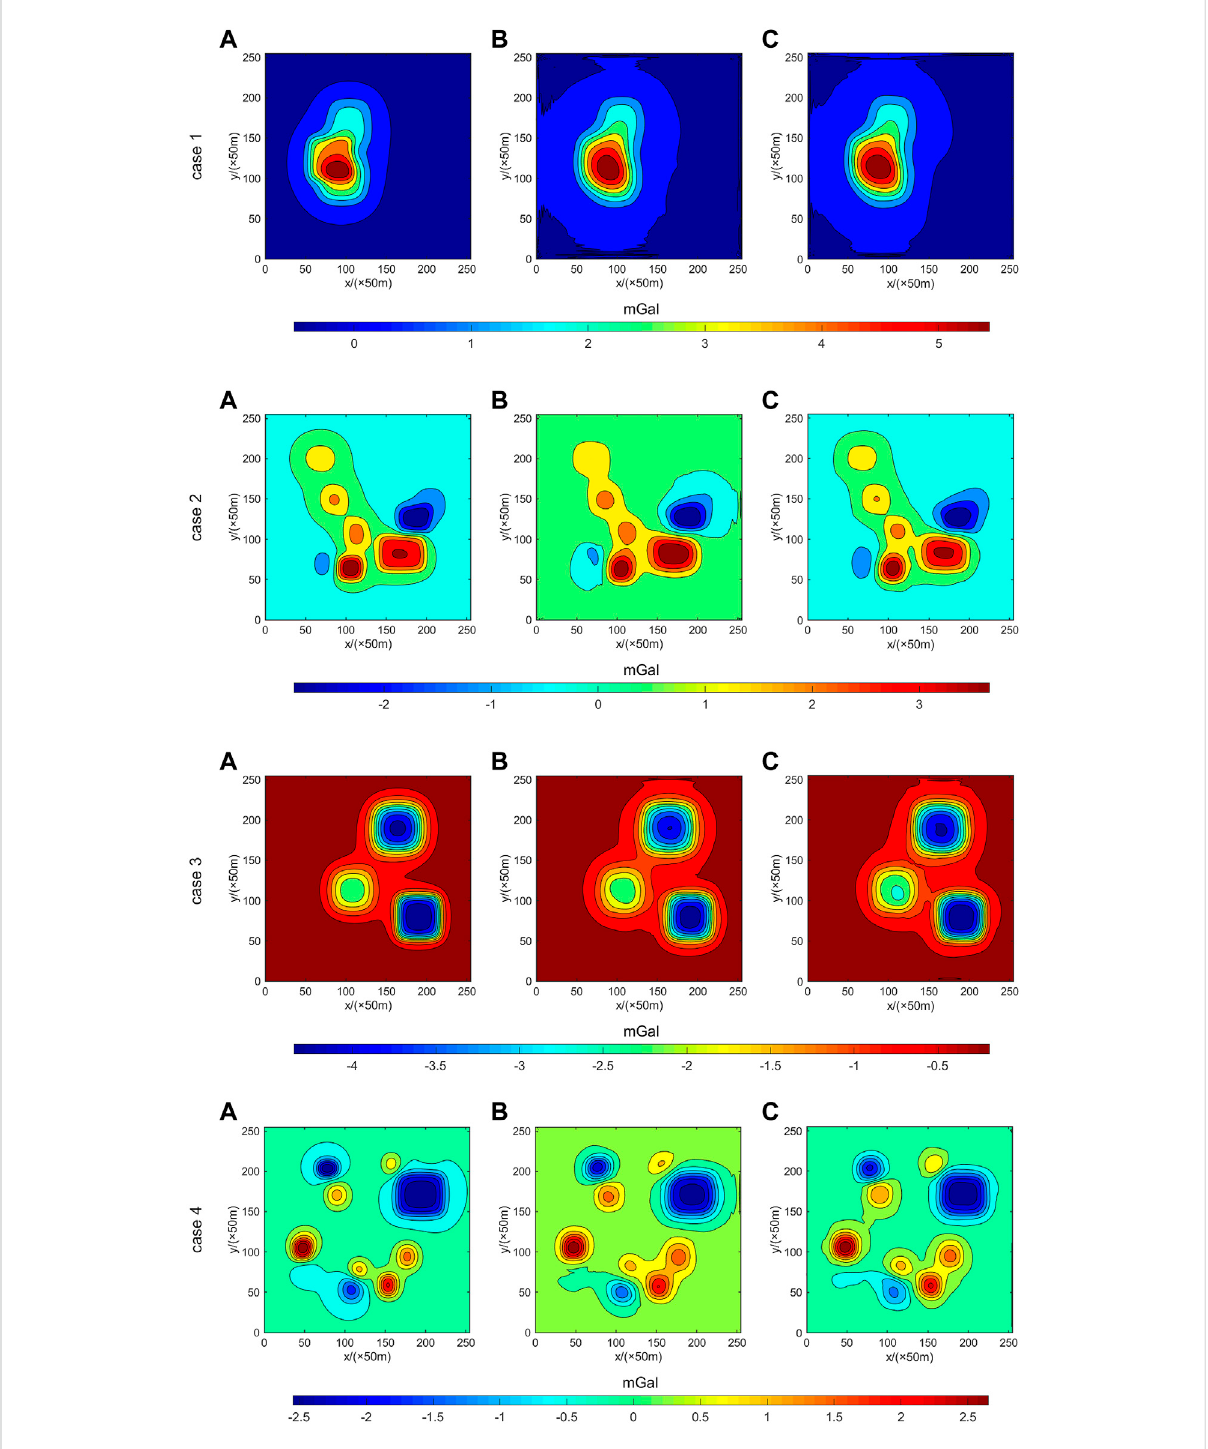
FIGURE 10 Comparisonof four different casesbetween theoretical potential fi eld data (A) , joint drivendata ( 2 input ) (B) , andjoint drivendata withnoise ( add noise ) (C)